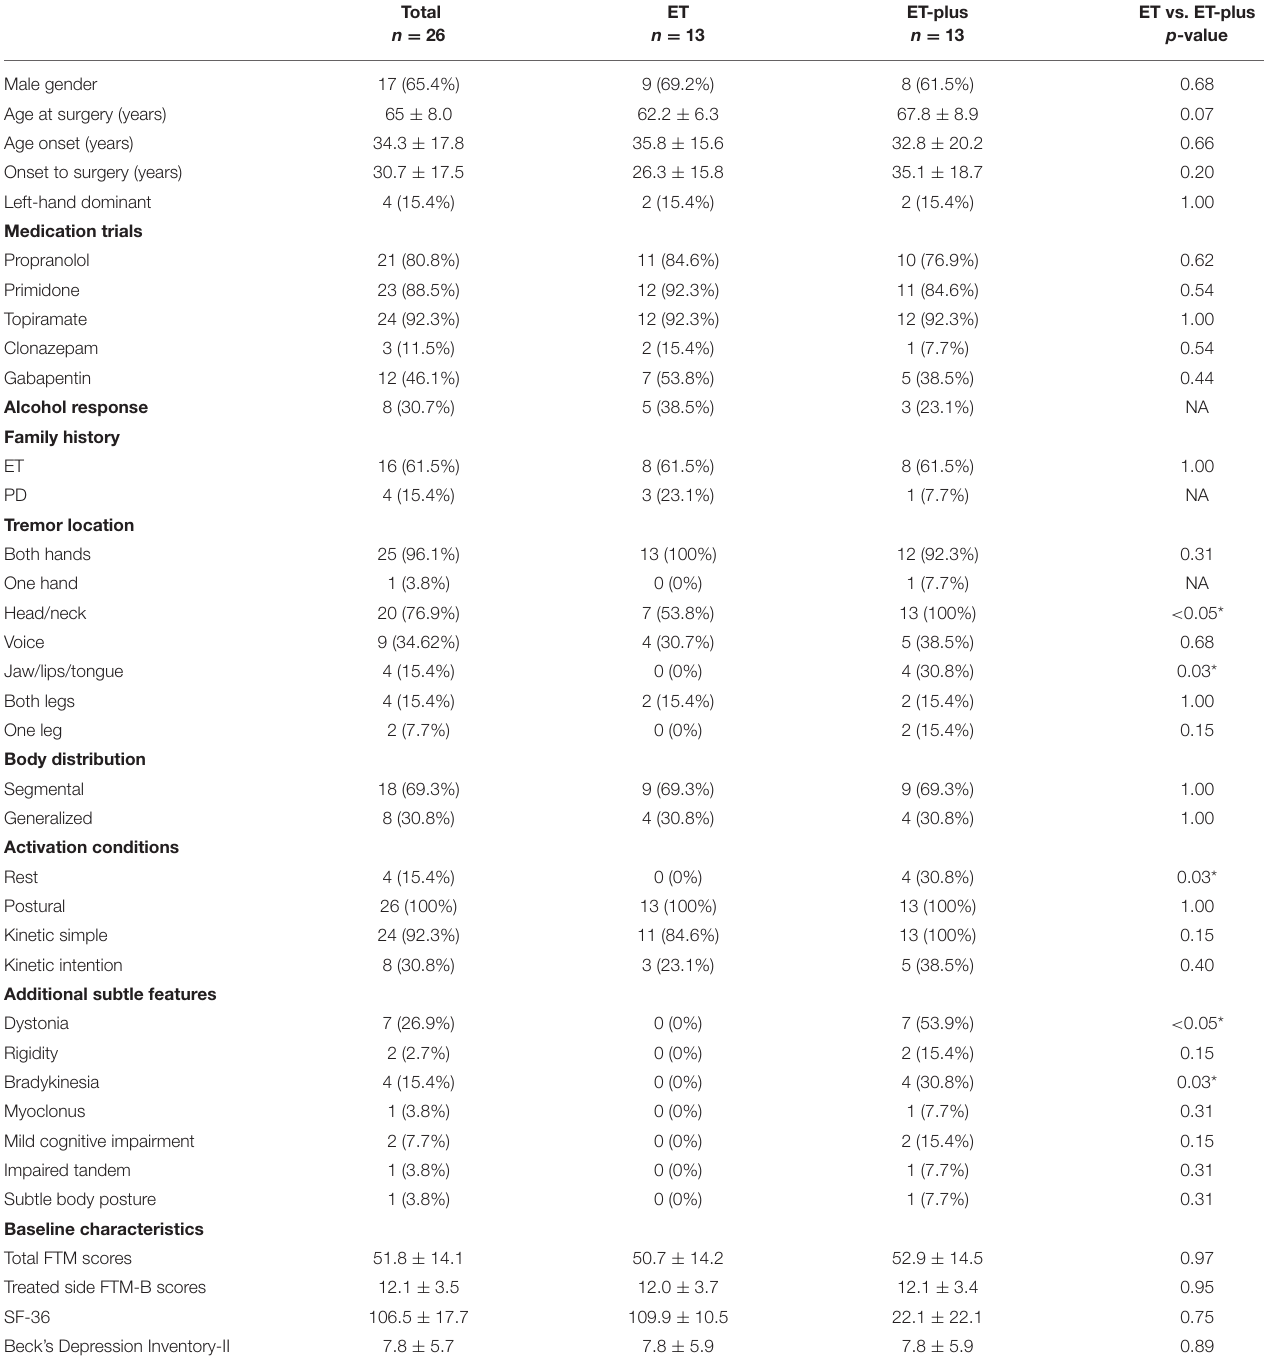
TABLE 1 | ET vs. ET-plus clinical characteristics.